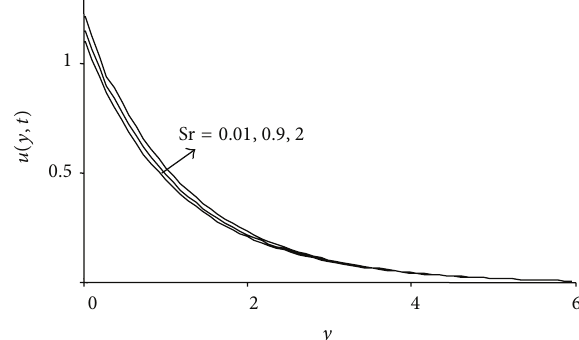
Figure 6: Velocity profiles for Pr eff = 0 . 350 ( 𝑁 𝑟 = 1, Pr = 0 . 7), Figure 9: Velocity profiles for 𝐾 𝑝 = 0 . 7, 𝑡 = 0 . 9, and different values 𝑡 = 1 . 2, and different values of 𝐾 of Sr when the plate applies constant shear stress 𝑓 = − 0 . 25. 𝑝 when the plate applies constant shear stress 𝑓 = − 0 . 25.